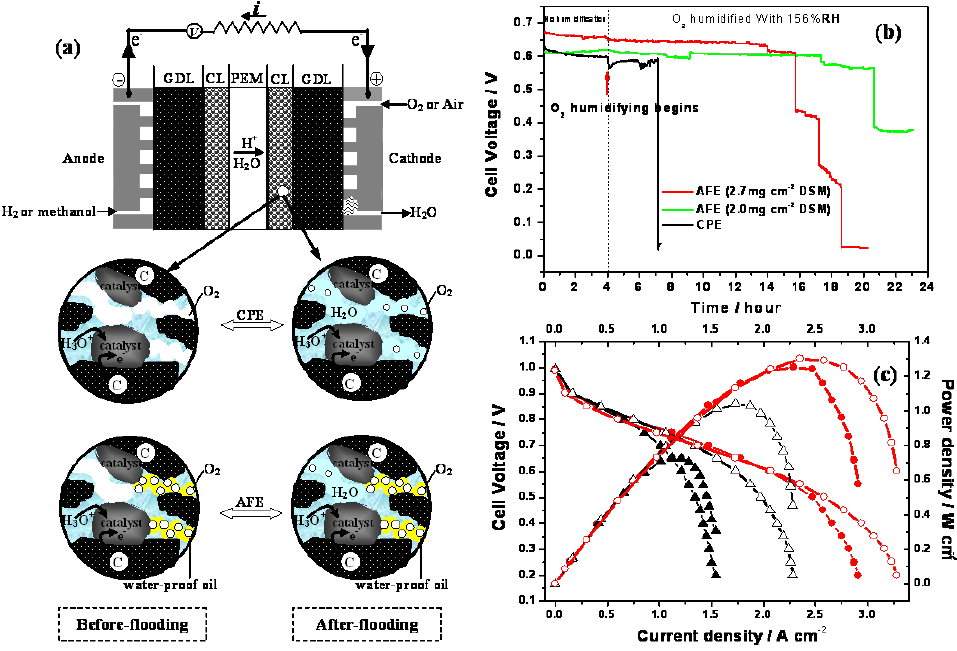
Time of a MEA with an AFE or CPE as the cathode at a current density of 1A cm -2 (b), and Cell voltage and Power density vs. Current density of a single cell (c) with a CPE anode and an AFE cathode in the case of no O RH (●), and a single cell with two CPEs in the case of no O over-humidification at 156% RH (▲).